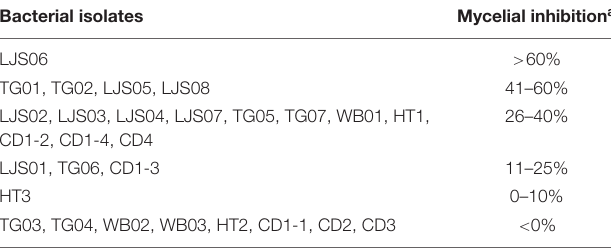
TABLE 1 | Efficacy of bacterial strains on inhibiting the mycelial growth of Colletotrichum orbiculare COC3. Bacterial isolates Mycelial inhibition a